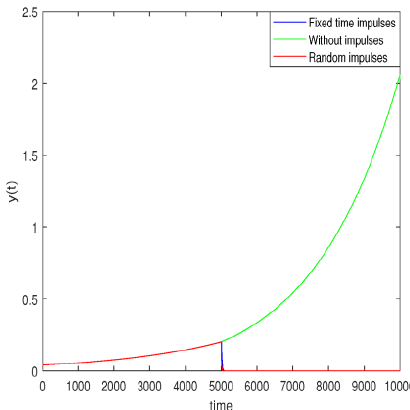
Figure 3. Shows that fixed impulsive effects, random impulsive effects and without impulsive effects of system ( 24 ) .